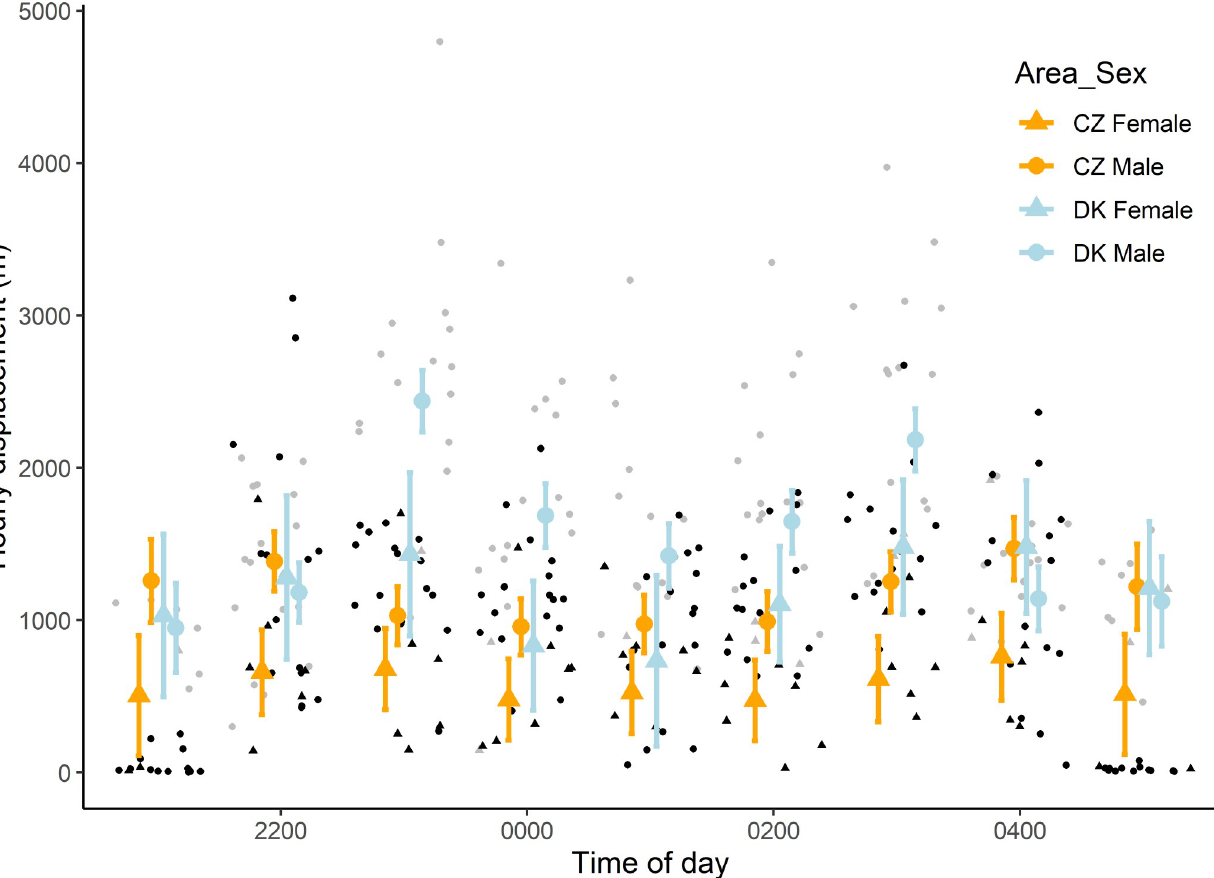
Fig 3. The predicted displacement per hour (large symbols) and 95% confidence intervals (bars) separately for Czech (orange) and Danish (light blue) little owls. Raw data are also shown separately for Czech (black) and Danish (grey) owls. Females are shown as triangles and males as circles.